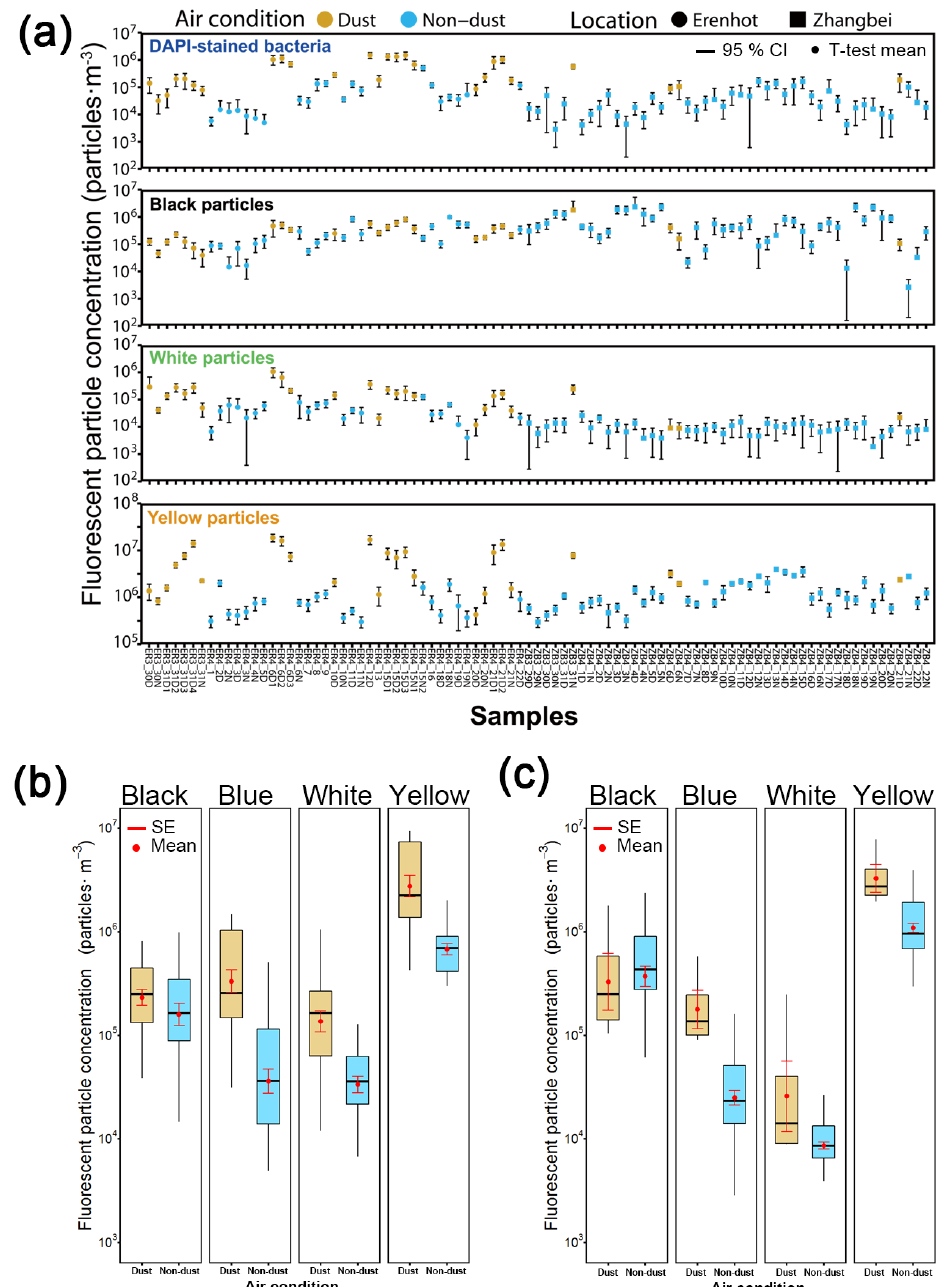
Figure 8. Changes in the concentrations of fluorescent particles in the samples (a) and a comparison of the concentrations of fluorescent particles in the samples collected during dust events and non-dust events in Erenhot (b) and Zhangbei (c) (black: black particles, blue: DAPI-stained bacteria, white: white particles, yellow: yellow particles, CI: confidence interval, SE: standard